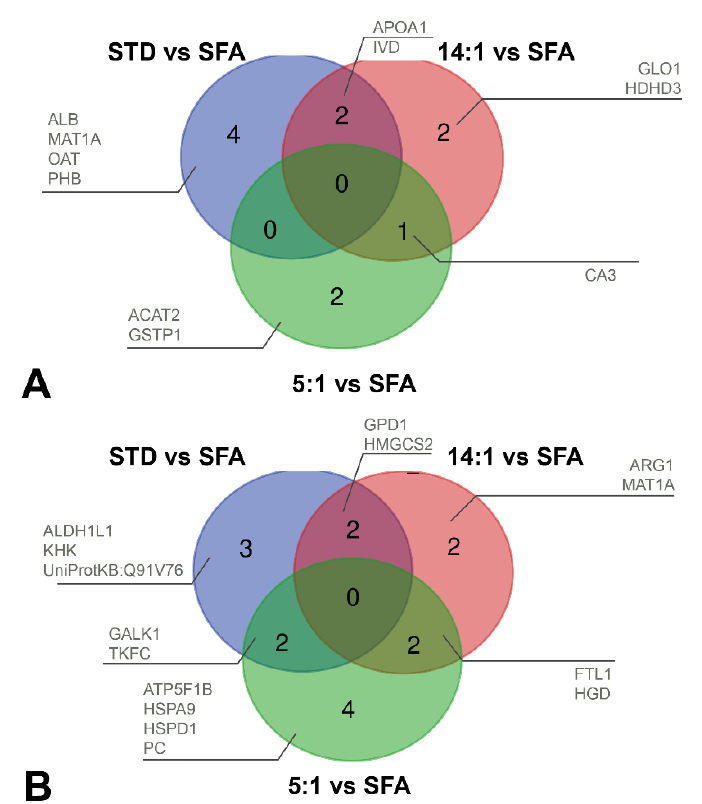
Figure 11. Venn diagram of differentially expressed proteins after three-months diets. ( A ) The number and list of proteins with increased expression in the STD (blue), 14:1 (red) and 5:1 (green) groups compared to the SFA. ( B ) The number and list of proteins with decreased expression in the STD (blue), 14:1 (red) and 5:1 (green) groups compared to the SFA.